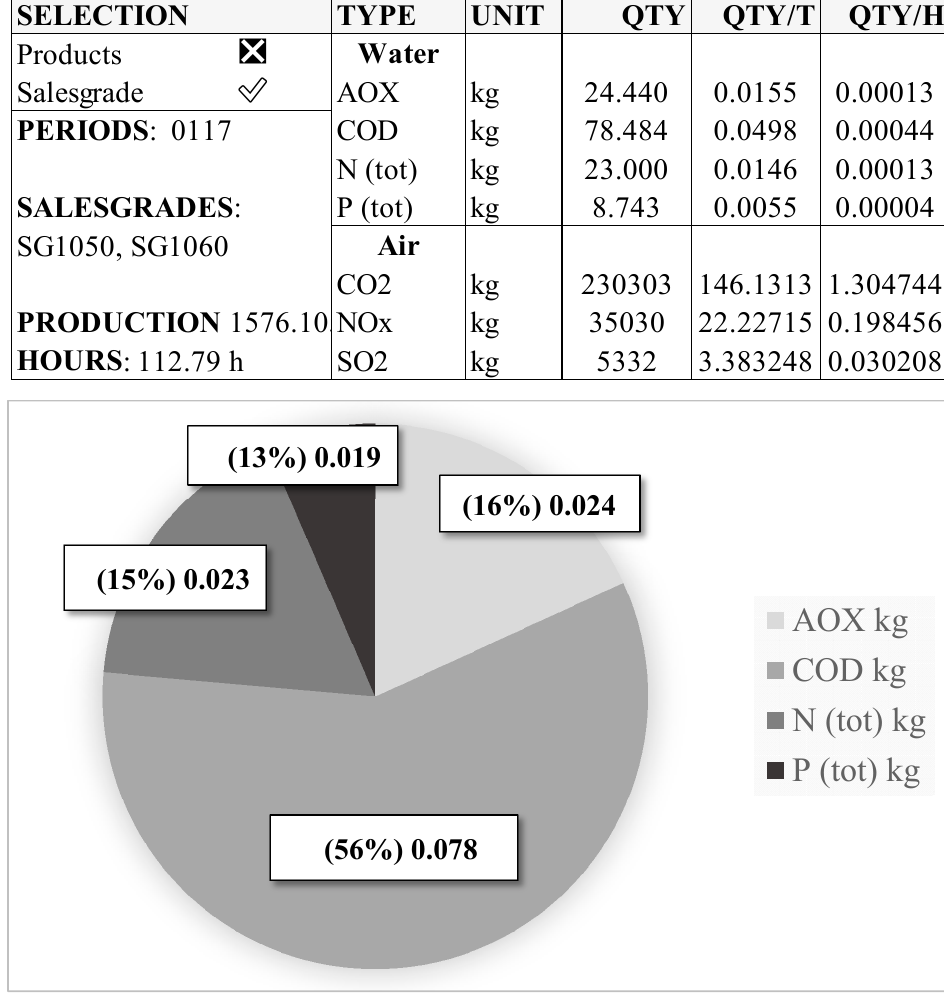
Figure 5. A report example of emissions to water and air.